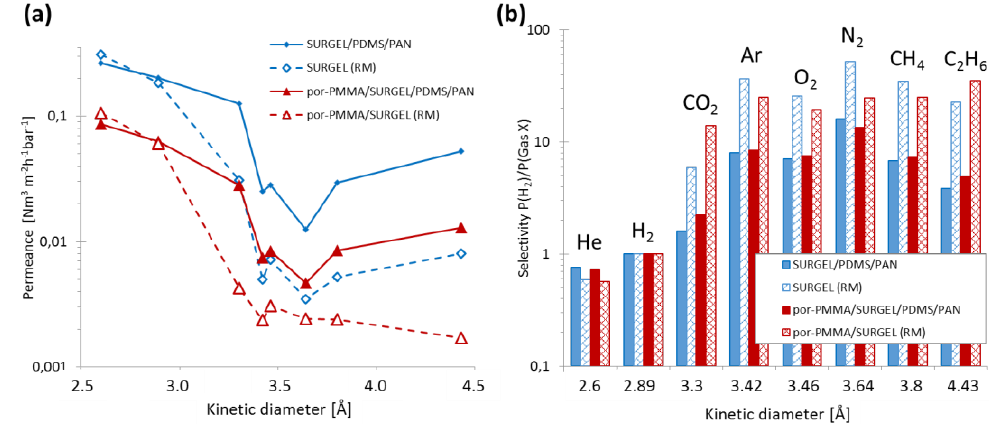
Figure 6. ( a ) The permeance of the TFC SURGEL membranes and the calculated permeances of the SURGEL layers alone, by applying the series resistance model (RM); ( b ) selectivities of the TFC SURGEL membranes and the individual SURGEL selective layers after applying the series resistance model (RM).